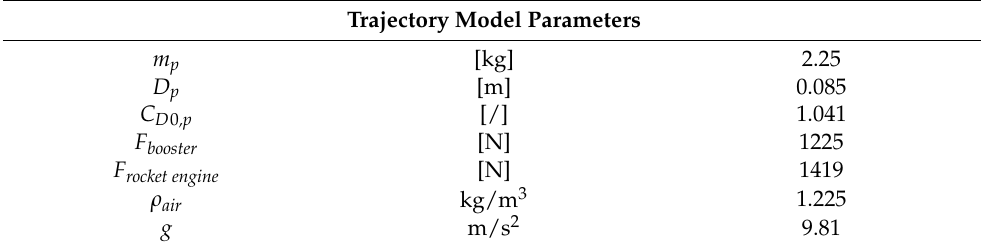
Table 8. Parameters for the PG-7 trajectory